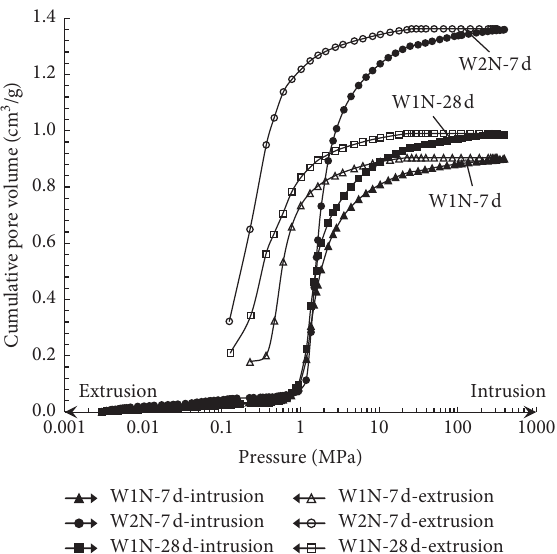
Figure 10: Mercury intrusion and extrusion curves of NCG